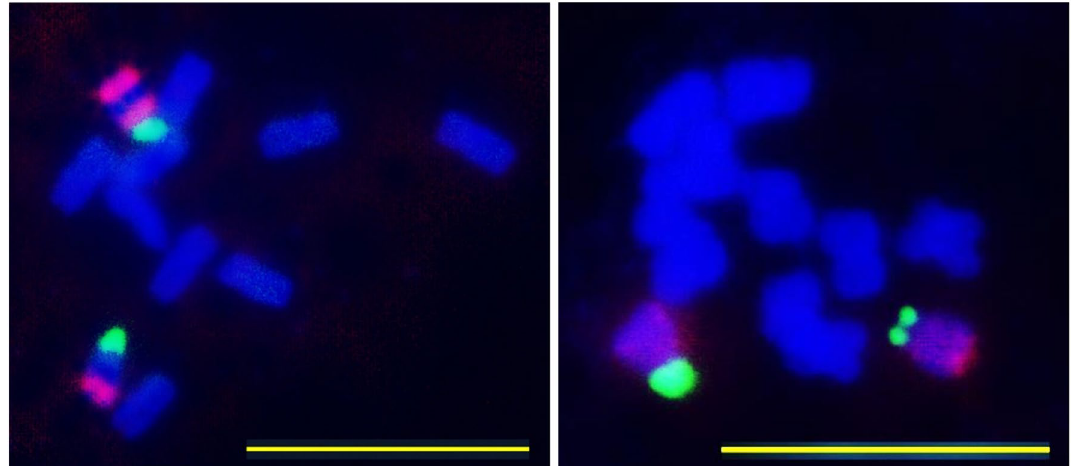
Fig. 6 FISH mapping of 35S (green) and 5S rDNA (red) on somatic metaphase chromosomes of Plantago maxima (2 n